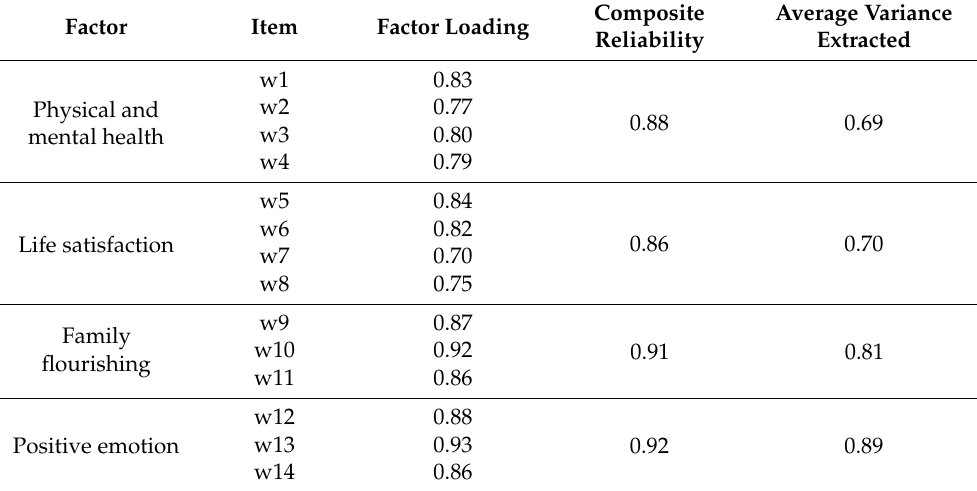
Table 6. Test results of the recreational sport’s well-being scale’s reliability and convergent